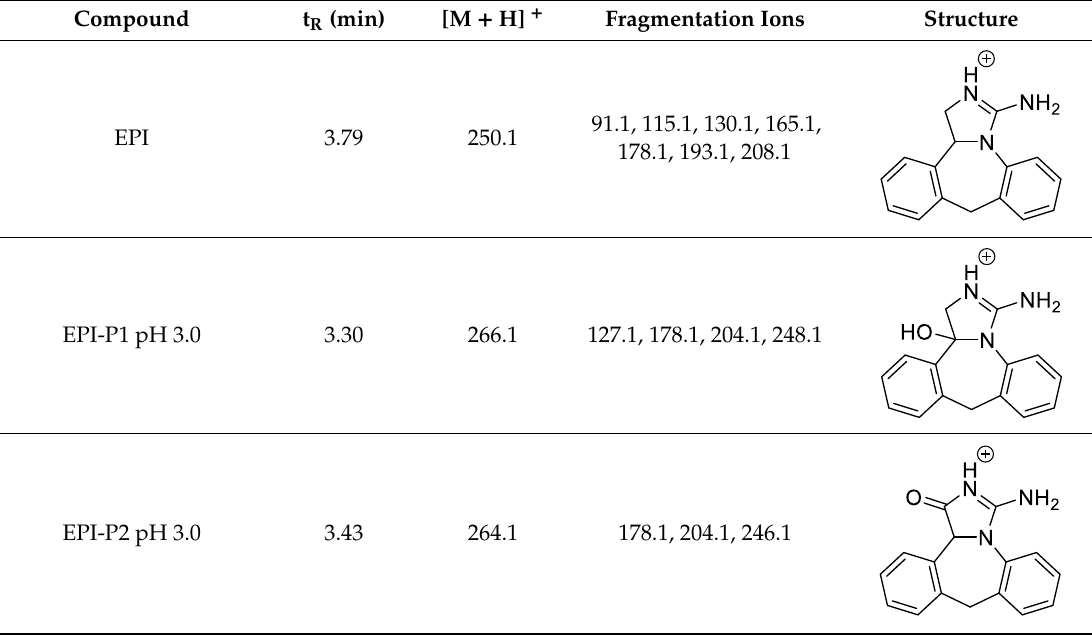
Table 4. Proposed structures of the photodegradation products of epinastine (EPI).